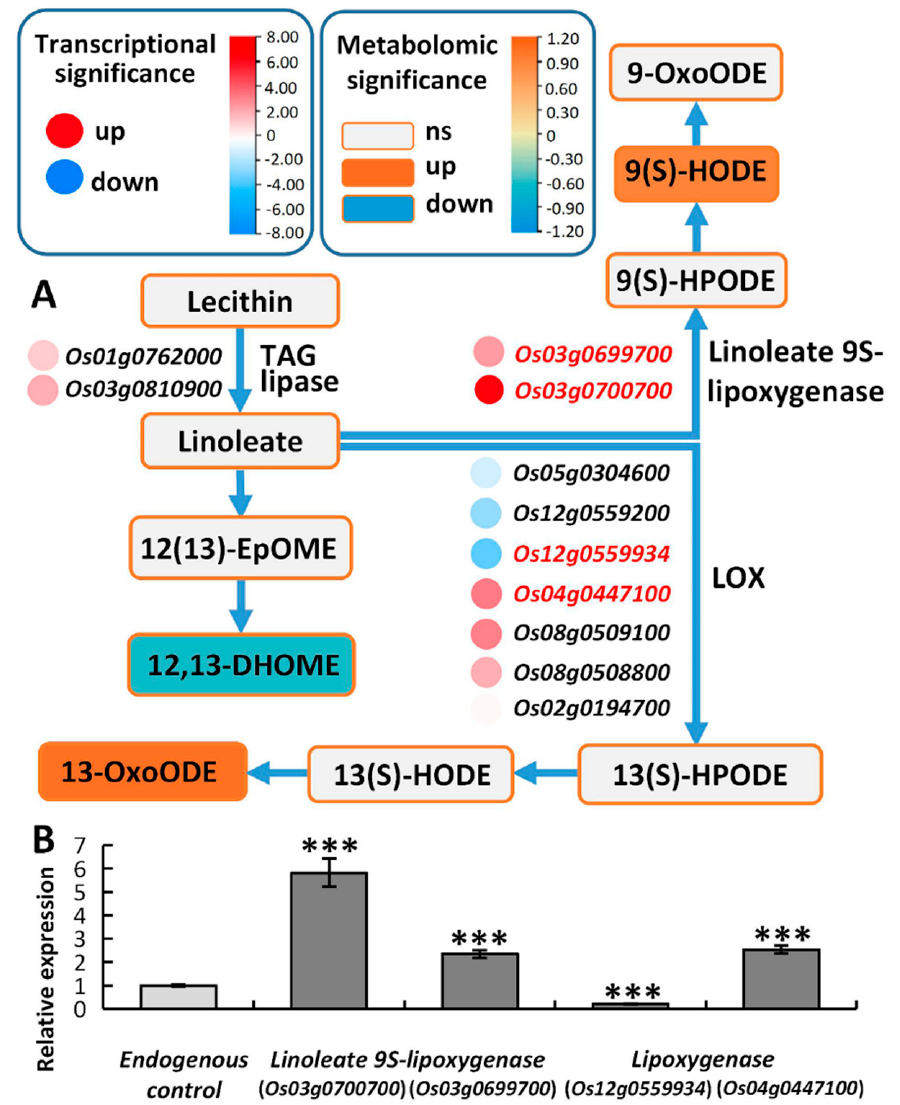
Figure 9. Overview of the linoleic acid metabolism pathway in response to HSA stress. ( A ) The DEGs and related DAMs involved in linoleic acid metabolism. The meanings of rectangles, circles, colors, and lines are the same as those in Figure 7. ( B ) Data are presented from three independent experiments performed with three replicates per experiment. ***, p < 0.001; Student’s t-test. Triacylglycerol lipase (TAG lipase).